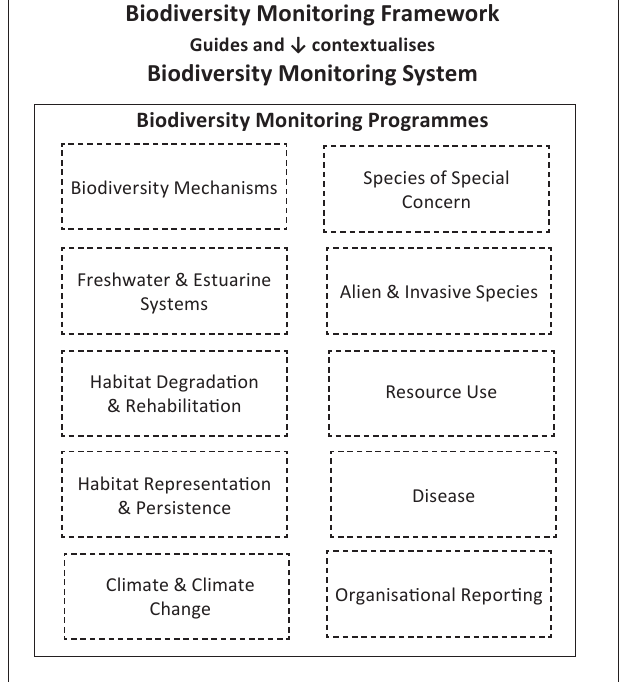
FIGURE 2: SANParks’ Biodiversity Monitoring System (BMS) is composed of a number of Biodiversity Monitoring Programmes (BMPs); the 10 Biodiversity Monitoring Programmes shown here are those that have been identified for development and adoption.